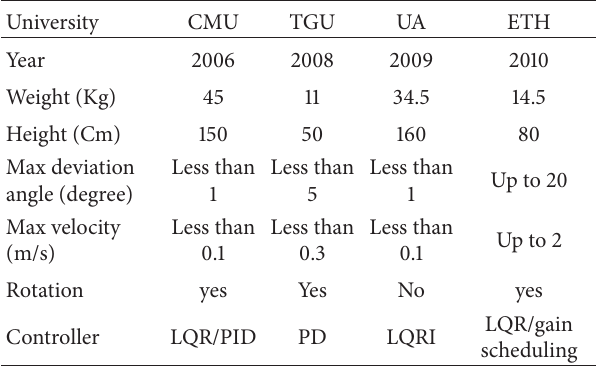
Table 1: Comparison of characteristics of four Ballbot